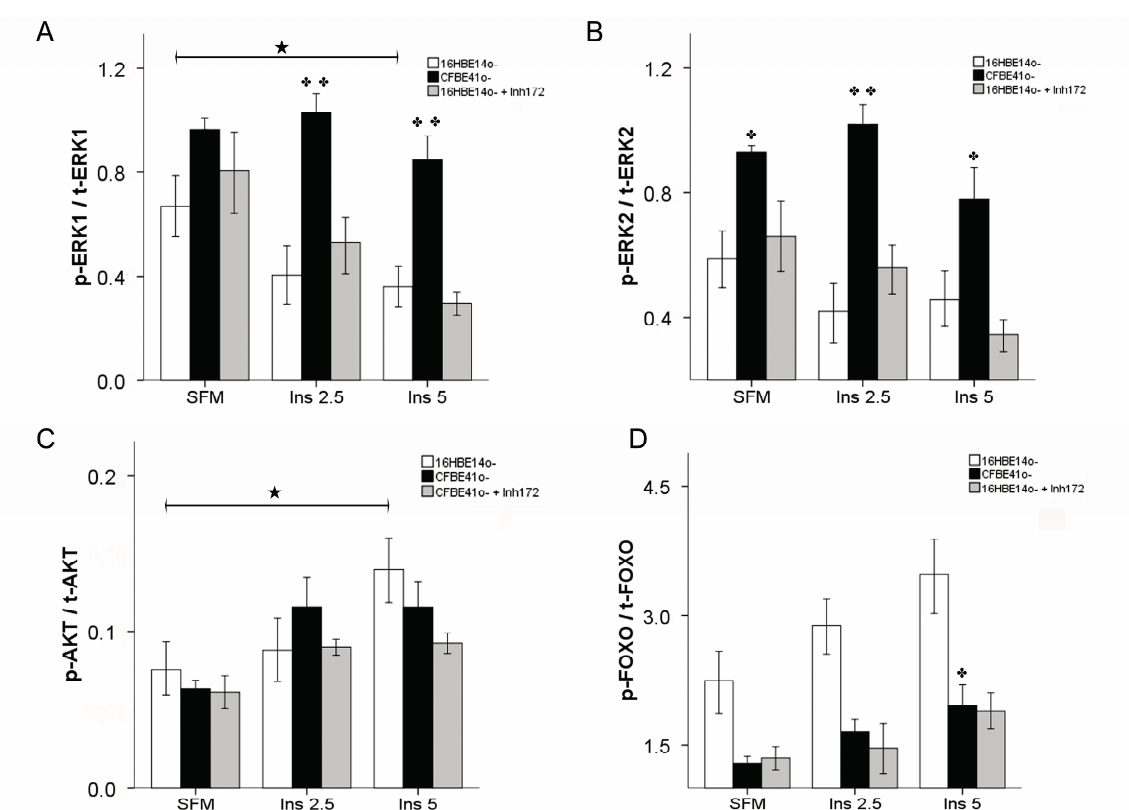
Figure 5. Activated [T202/Y204]/total ERK1 (p-ERK1/t-ERK1) ratio ( A ), activated [T185/Y187]/total ERK2 (p-ERK2/t-ERK2) ratio ( B ), activated [S473]/total AKT ratio (p-AKT/t-AKT) ( C ), and phosphorylated [S256]/total FOXO1 (p-FOXO1/t-FOXO1) ratio ( D ). ( A ) The p-ERK1/t-ERK1 ratio was similar in both cell lines in serum-free medium (SFM). After insulin stimulation, the ratio was significantly higher in the CFBE41o- cells compared with the normal cells. After treatment of 16HBE14o- cells with the CFTR inhibitor, no significant change was observed; ( B ) The p-ERK2/t-ERK2 ratio was significantly higher in the CFBE41o- cells compared with the normal cells in all conditions. CFTR inhibition in 16HBE14o- cells did not recreate the CF status; ( C ) Inh172 treatment of 16HBE14o- cells did not modify the p-AKT/t-AKT ratio in baseline conditions (SFM). After insulin stimulation at 5 ng/mL, the ratio was similar to the one found in CFBE41o- cells; ( D ) Inh172 treatment of 16HBE14o- cells lowered the p-FOXO1/t-FOXO1 ratio, in all conditions, to values similar to those found in the CFBE41o- cells. Bars represent the mean ± SEM of all experiments in both groups ( n = 4). p < 0.05 CFBE41o- vs . 16HBE14o-;